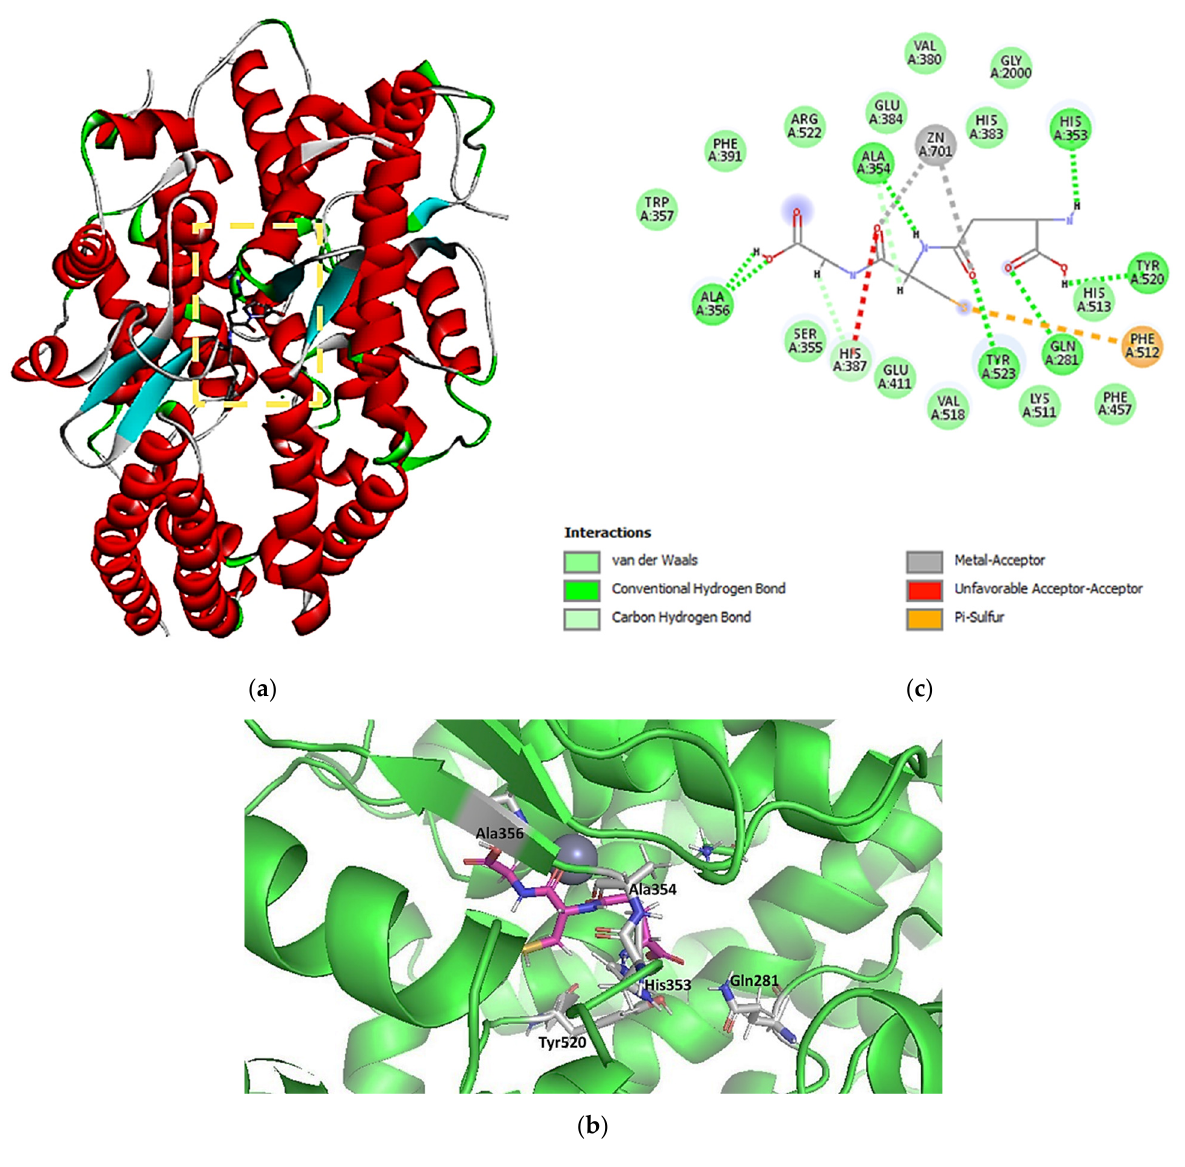
Figure 12. Crystal structure of lisinopril complexed with lisinopril ( a ); 2D ( b ) and 3D ( c ) forms of interaction between glutathione with the ACE binding site (pose 1; PDB ID: 1O86).